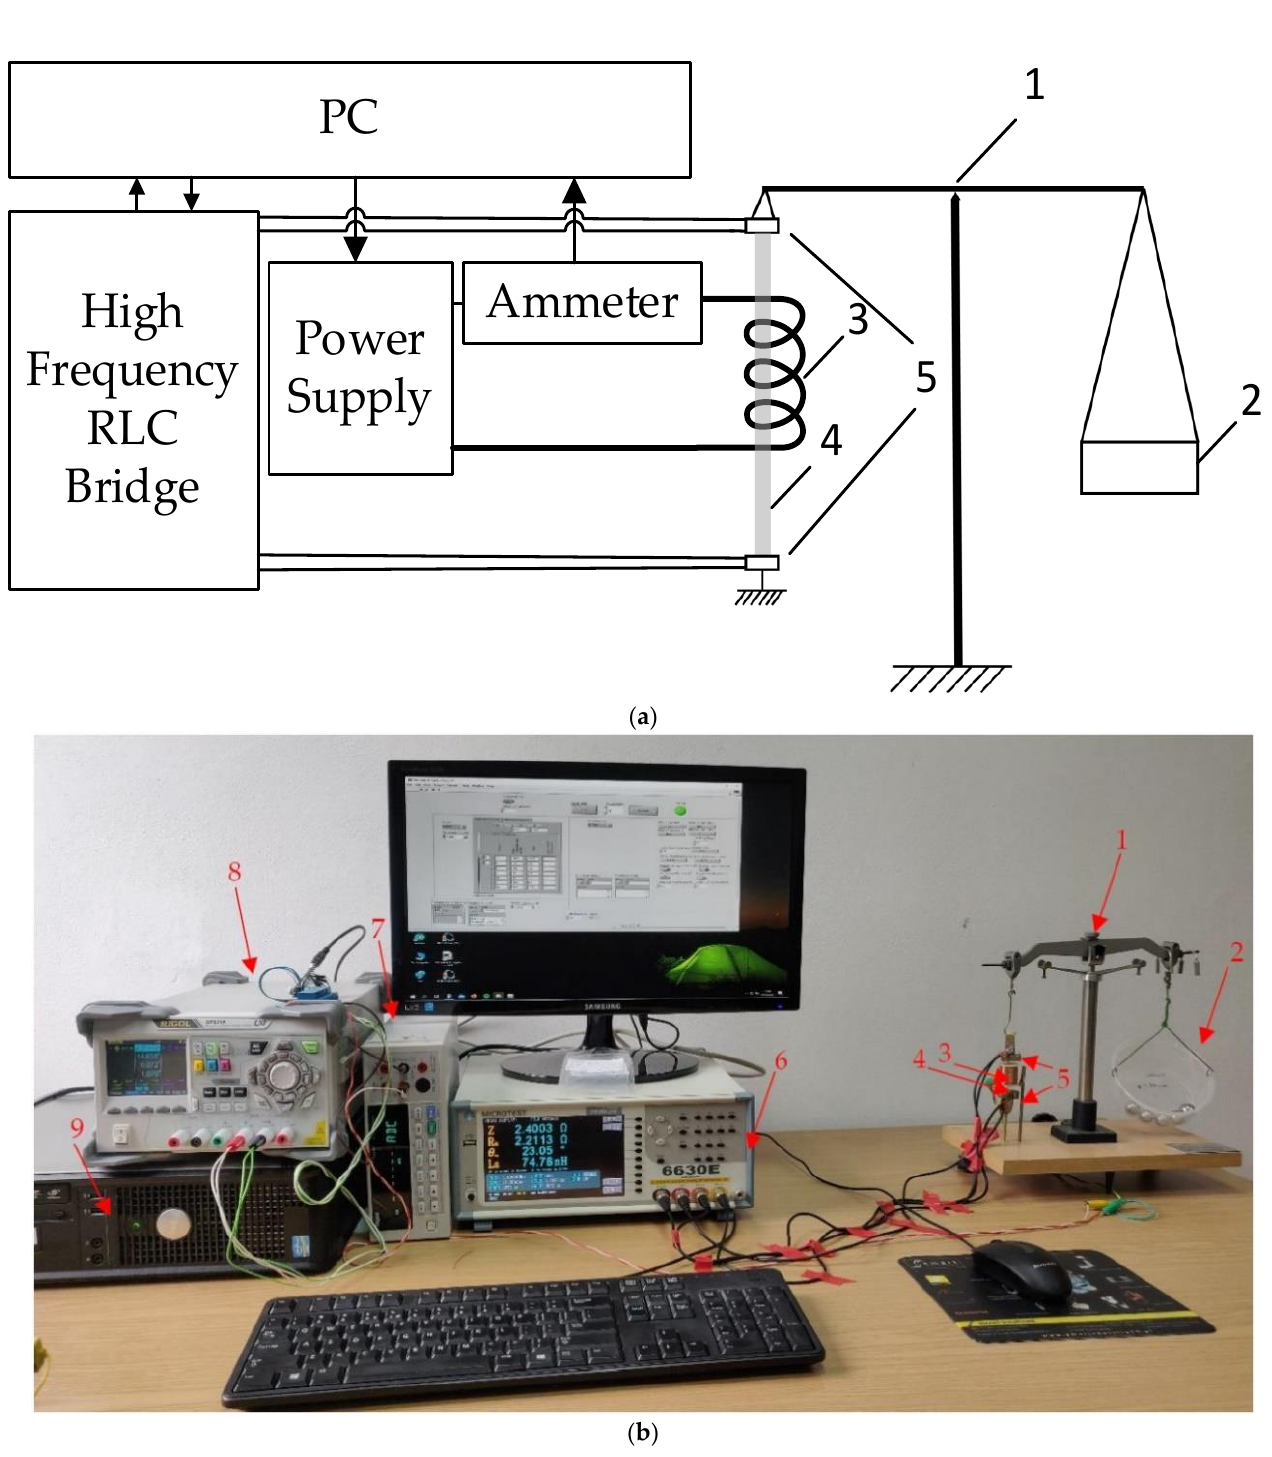
Figure 2. Developed test stand: ( a ) block diagram of the developed stand; ( b ) photo of the developed stand for testing stress-impedance in a function of the external magnetic field. The diagram and the photo contains: 1 — balance scale, 2 — applied mass, 3 — magnetizing coil, 4 — tested sample, 5 — electrodes/measuring holders, 6 — high-frequency RLC bridge, 7 — ammeter, 8 — laboratory power supply, 9 — PC computer.